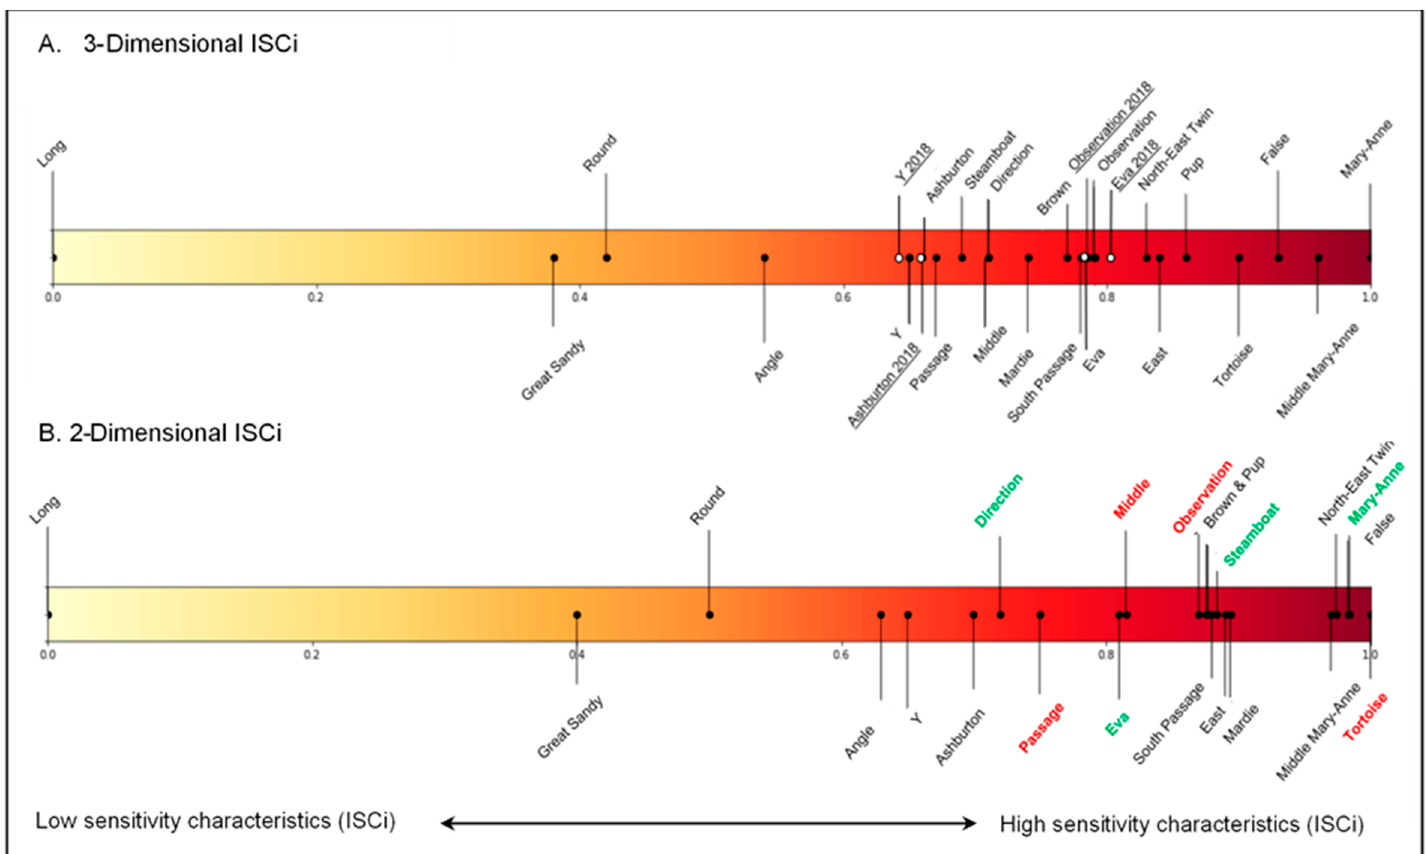
Figure 7. ( A ) Full 3D Island sensitivity characteristics index (ISCi) ranking N = 22 reef islands using Principle Component Analyses (PCA) of the 2016 LiDAR (black dots) and 4 additional islands (Eva, Y, Ashburton, and Observation) from the 2018 LiDAR (white dots) and ( B ), 2D ISCi ranking N = 22 islands using PCA of 2016 LiDAR. Examples of islands that increased (e.g., Observation; red) and decreased (e.g., Direction; green) in sensitivity on the 2D ISCi compared to the 3D ISCi demonstrate a change in island position. The ISCi is statistically normalized to an arbitrary scale between 0 and 1, where 0 indicates islands of low sensitivity characteristics and a value of 1 indicating islands of high sensitivity characteristics.